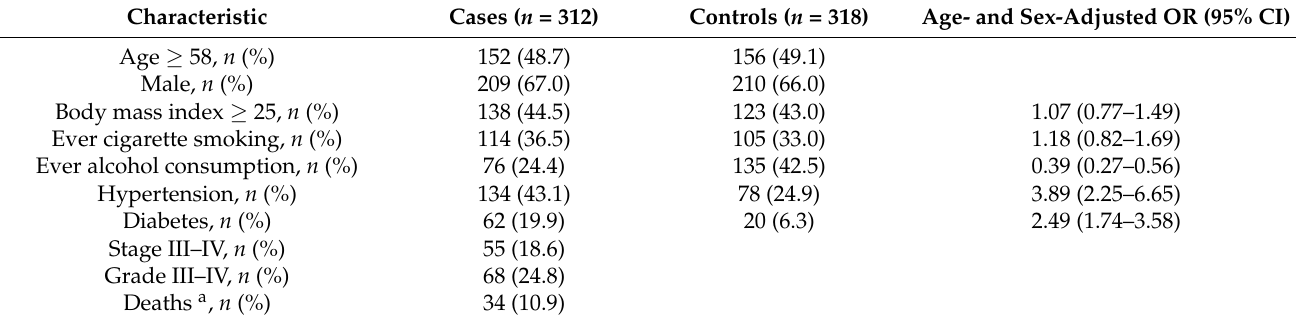
Table 1. The clinical characteristics of the study population.